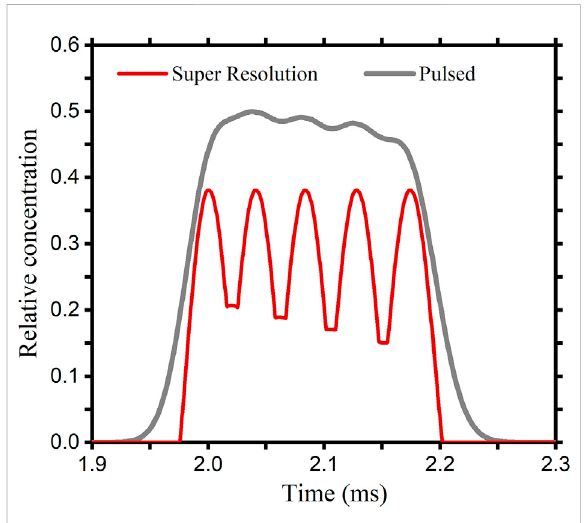
Effect of different initial width on the inverse diffusion counterbalance